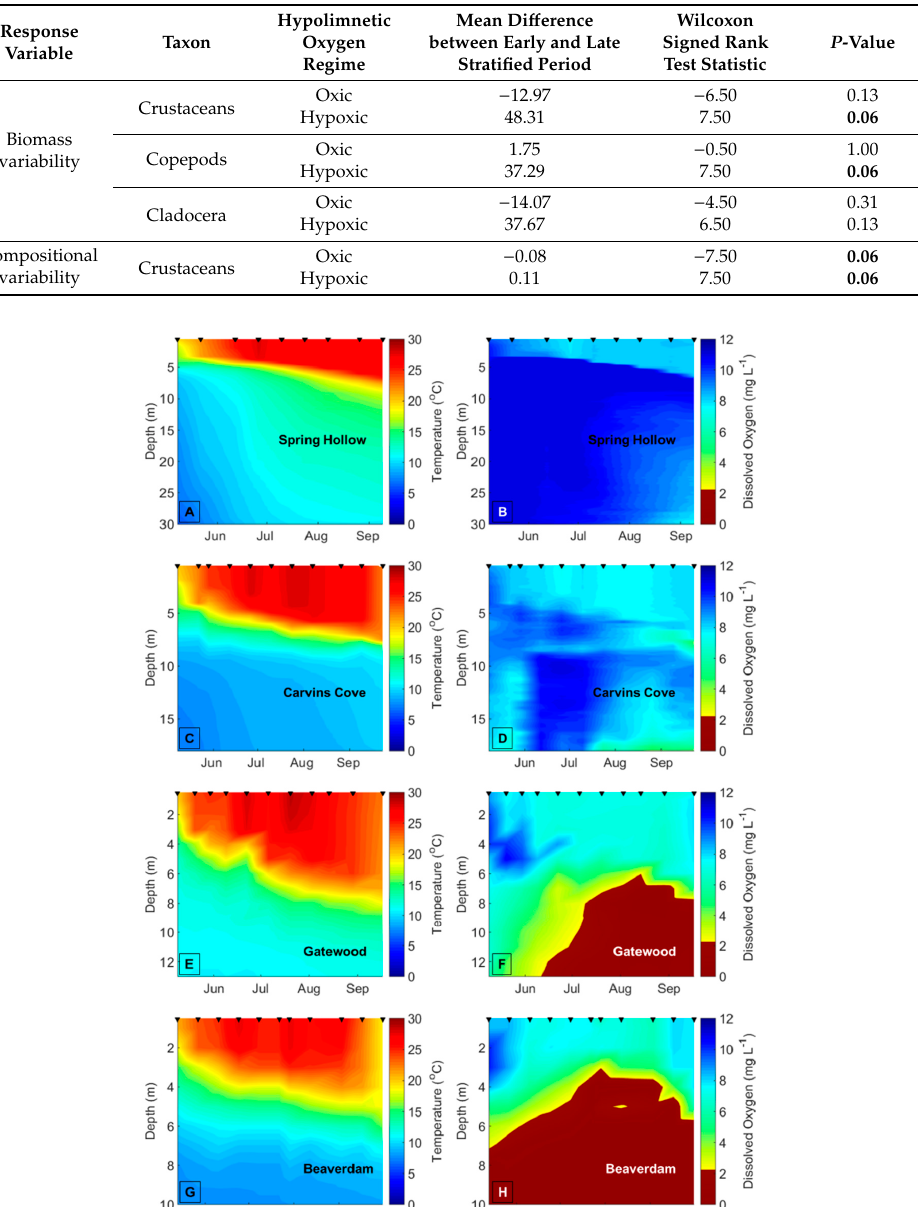
Table A2. Wilcoxon signed rank test statistics of the di ff erence in crustacean zooplankton, cladoceran and copepod biomass variability and the compositional variability of crustacean zooplankton biomass between the early (when all reservoirs were oxic) and late stratified periods across years in oxic and hypoxic reservoirs, when the breakpoint between the early and late stratified period was 1 week later than shown in Table 5. Only the compositional variability of total crustacean zooplankton (not individual copepod or cladocera group taxa) was calculated, because there were only two copepod taxa present in the reservoirs. A positive mean di ff erence tells us that the value increased from the early to late stratified period. Bold P -values highlight statistically significant ( P < 0.10) two-tailed P -values.